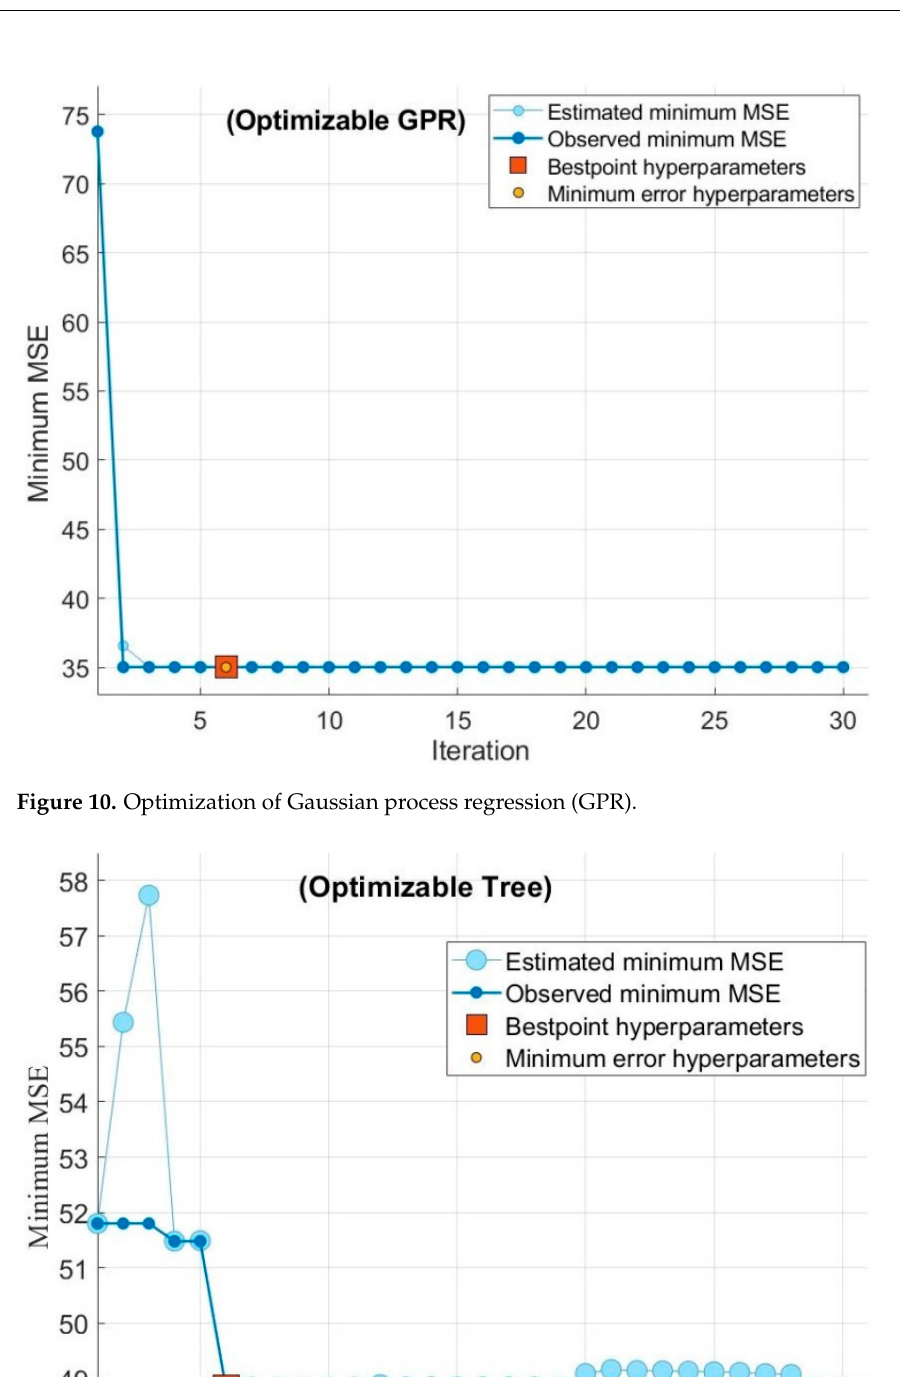
13 of 18 Figure 9. True vs predicted response. ( a ) GPR, ( b ) regression trees, ( c ) ANN. To protect the data against overfitting, it was partitioned into folds, and accuracy was estimated on each fold. A cross-validation fold value of 5.0 was selected for these data sets. These values are obtained by hit-and-trial experiments by tuning the hy- perparameters of the chosen models. It can be seen that GPR achieved the best accuracy in validation and testing, with R 2 values of 0.78 and 0.84, respectively. After GPR, the ANN performance was better ,with an R 2 value of 0.73 in validation; however, in testing, ANN performed worst among all three models. The computation cost was measured in terms of the training time of the algorithm to predict the data. The regression trees were superior in terms of training time with 0.358 s, while computation of ANN took 3.508 s, followed by GPR with the highest computation time of 4.259 s. Despite the high compu- tation time, it can be deduced that GPR’s performance is superior both in training and testing. To improve the performance of the existing models, hyperparameter optimization was performed by using Bayesian optimization with the objective of minimizing the cost function of MSE, as shown in Figures 10 and 11. The data set for this experiment is small, so the default number of iterations and time limit is used. The blue line shows the